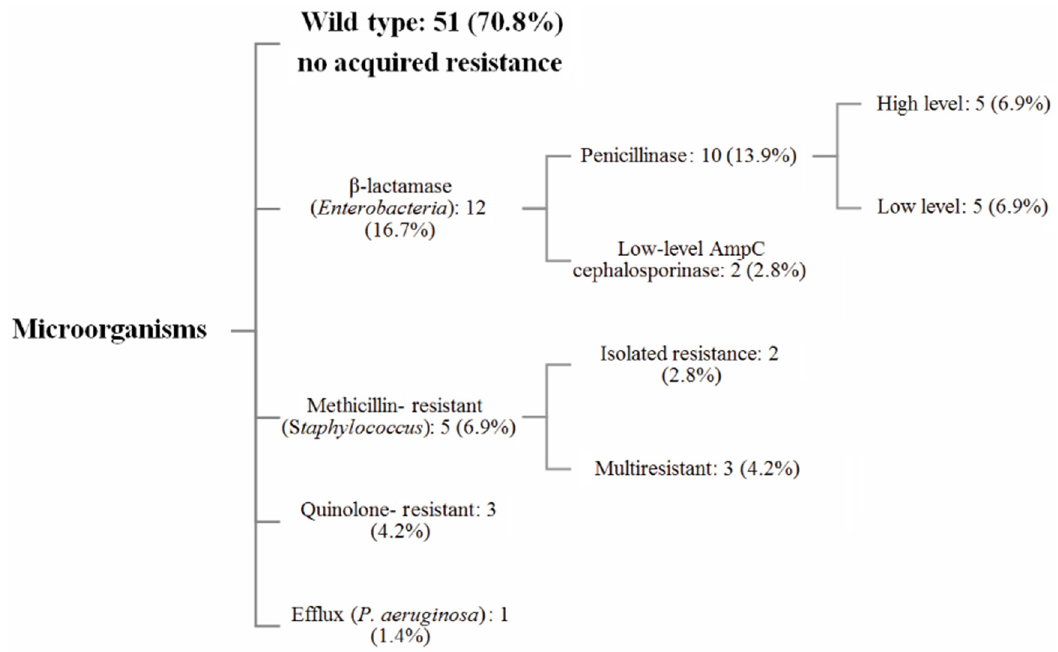
Figure 1. Representation of the resistance phenotypes of the microorganisms involved in the SSIs.